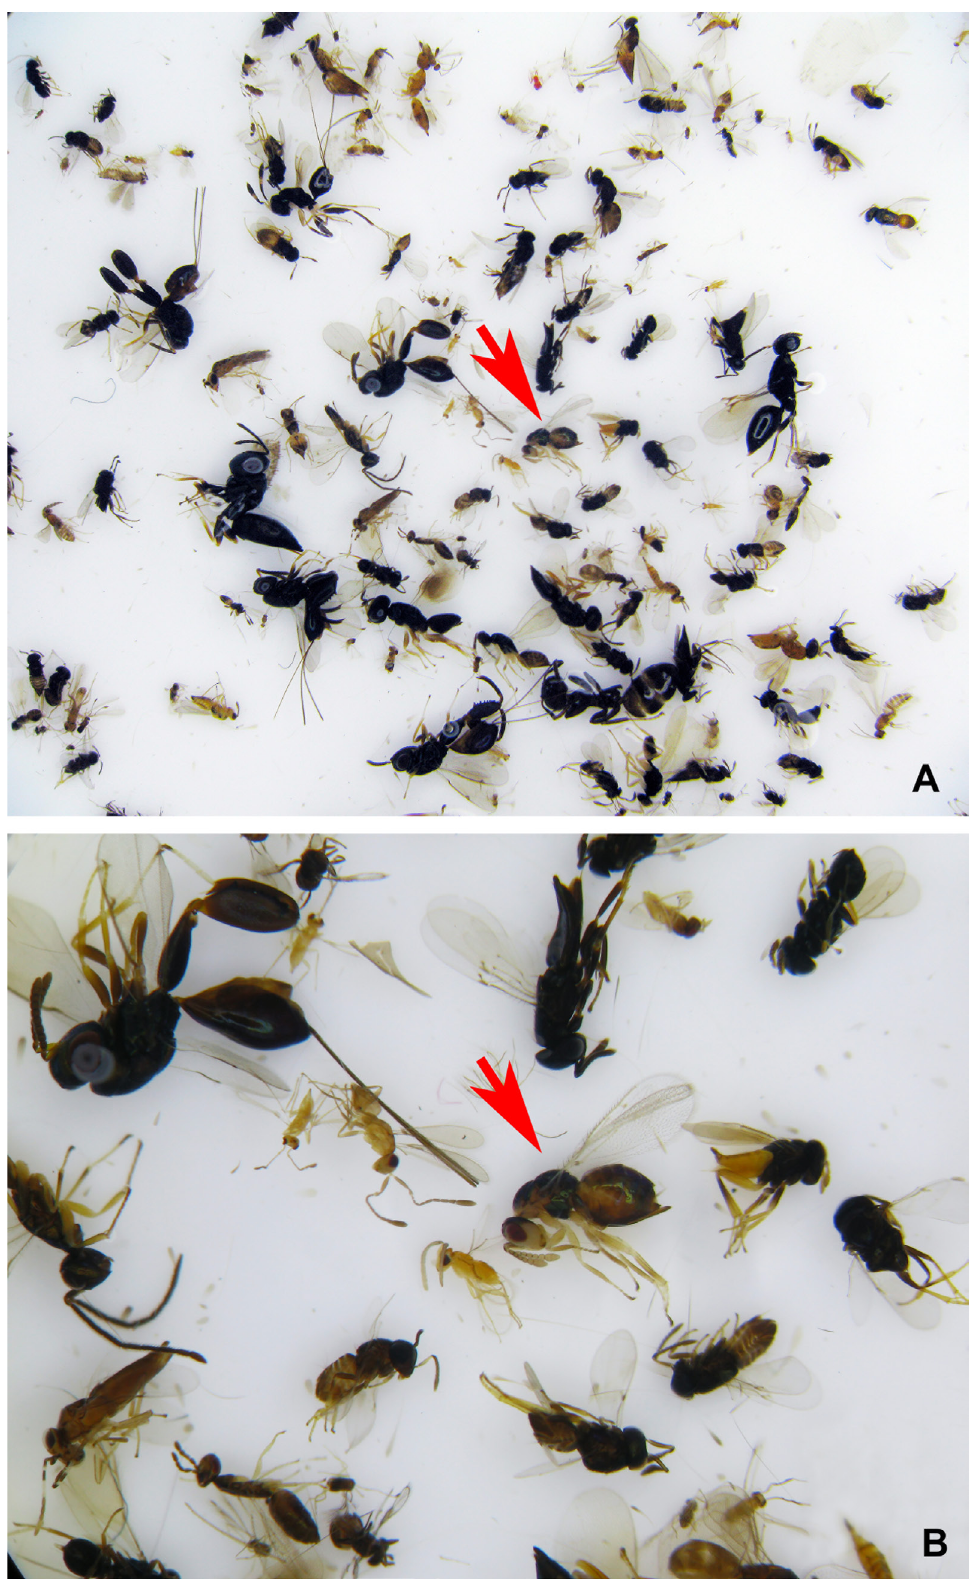
Fig. 1. Afrocampe prinslooi gen. et sp. nov., paratype (arrows), ♀, in a sample from the Grootvadersbosch Nature Reserve (Western Cape, South Africa) among other chalcidoid wasps. A–B .